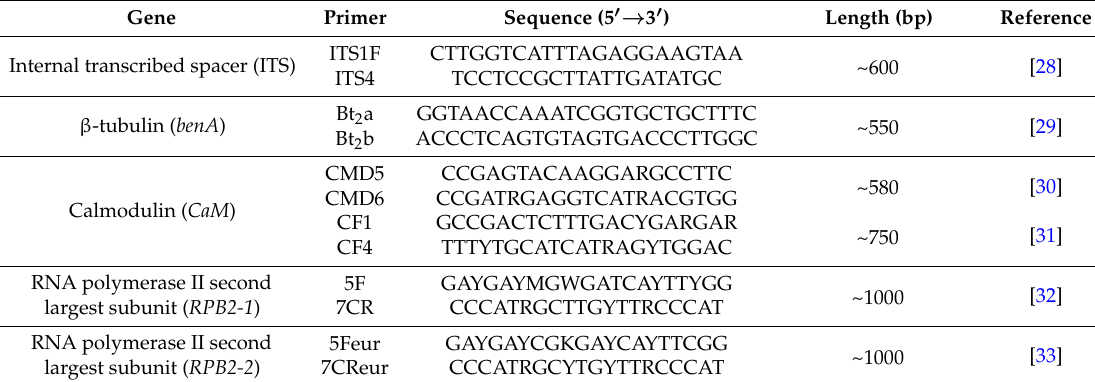
Table 1. Primers used for Penicillium species